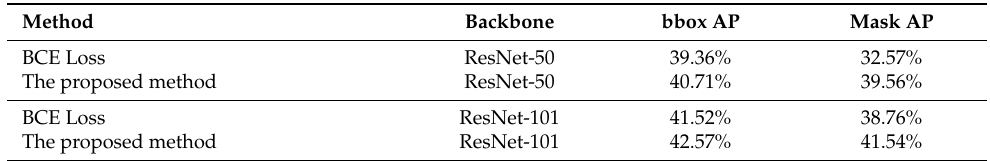
Table 4. Results of BCE Loss and the proposed method using ResNet-50 FPN and ResNet-101 FPN as backbones on the iSAID-Reduce100 val